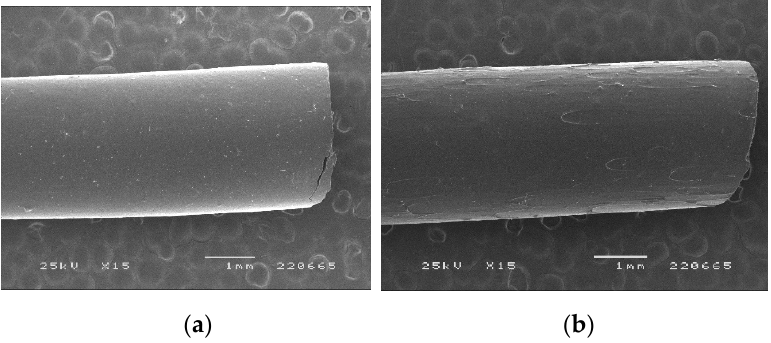
Figure 2. SEM images of PVA-based ( a ) placebo and ( b ) diazepam-loaded (10%)